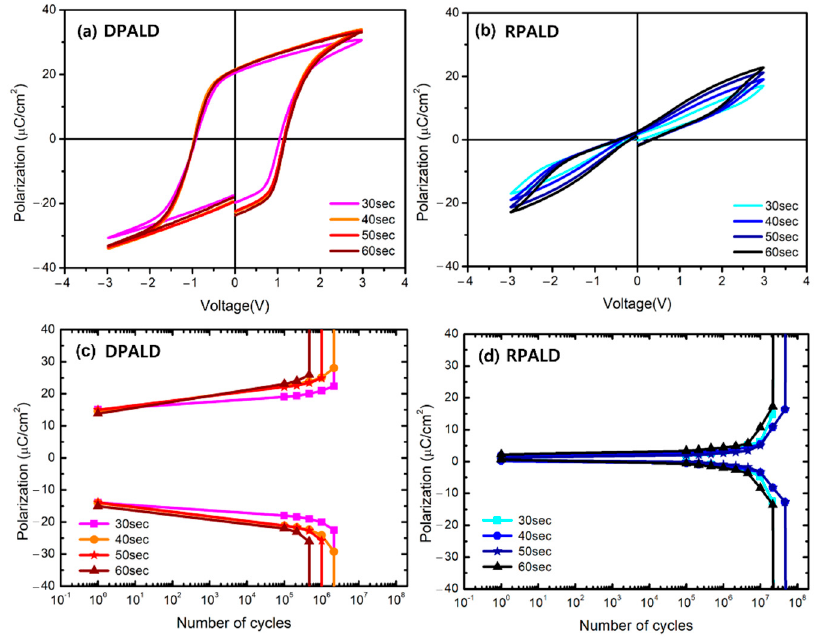
Figure 8. ( a , b ) The P–E hysteresis loop curve after 10 5 cycles and ( c , d ) the fatigue endurance prop- erty of HZO thin films deposited by two PEALD methods, according to the RTA time. of HZO thin films deposited by two PEALD methods, according to the RTA